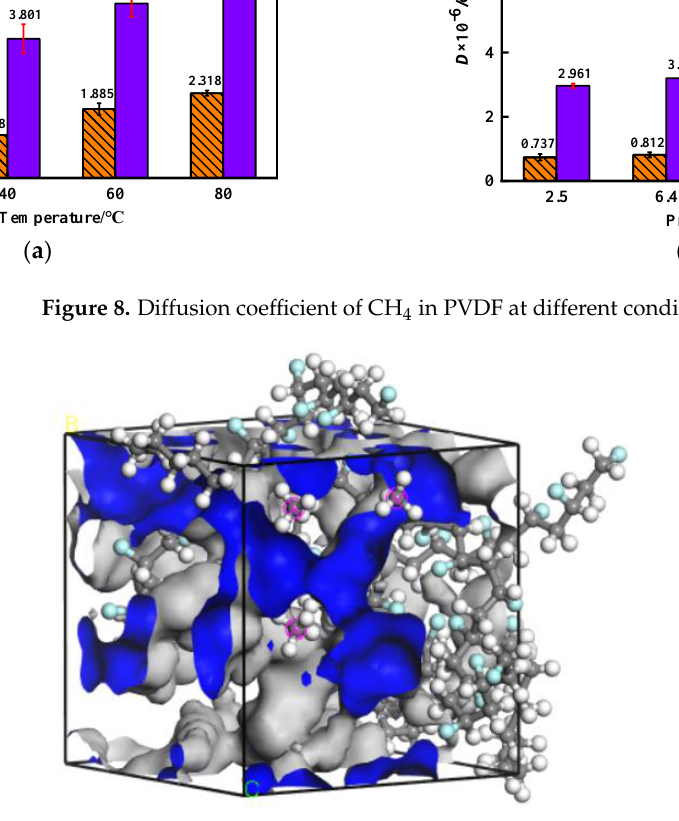
4 /(Oil + PVDF) cell.